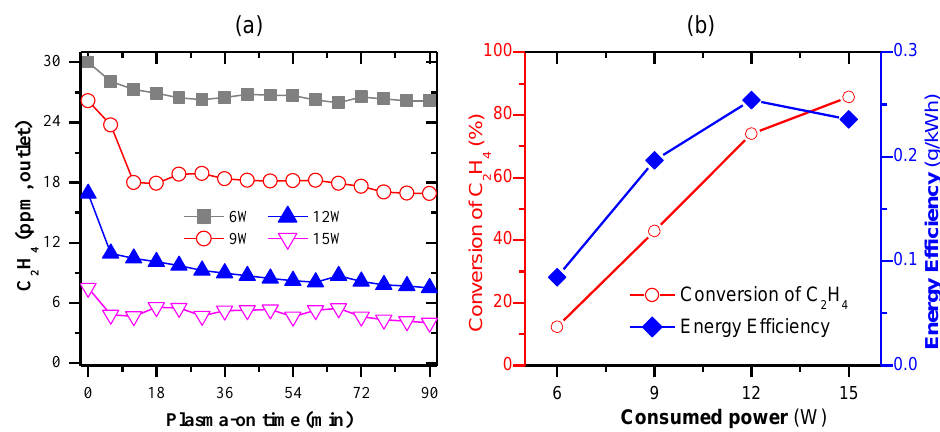
Figure 3. ( a ) Evolution of C 2 H 4 continuous process of the plasma-catalytic process under different applied powers and ( b ) conversion rate and energy efficiency at steady state (total flow rate of 2 L/min included 30 ppm C 2 H 4 and O 2 as balance).